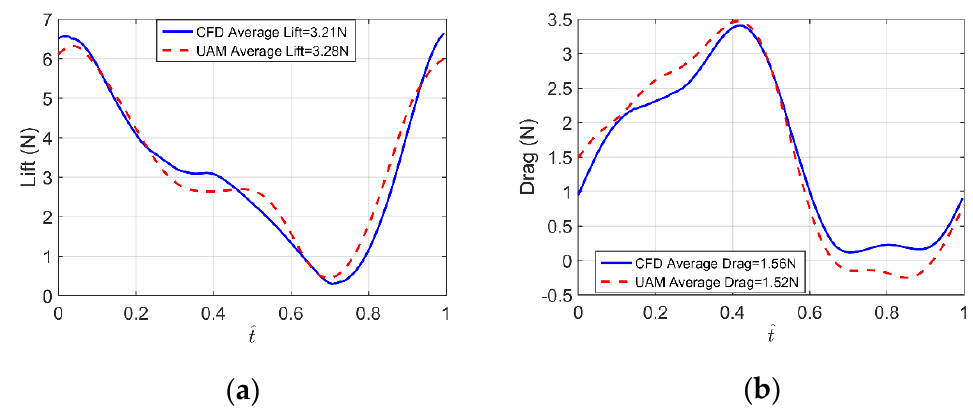
Figure 20. The lift force ( a ) and drag force ( b ) of the flapping wing with pitching angle 0°~60° at 4m/s by UAM and CFD.